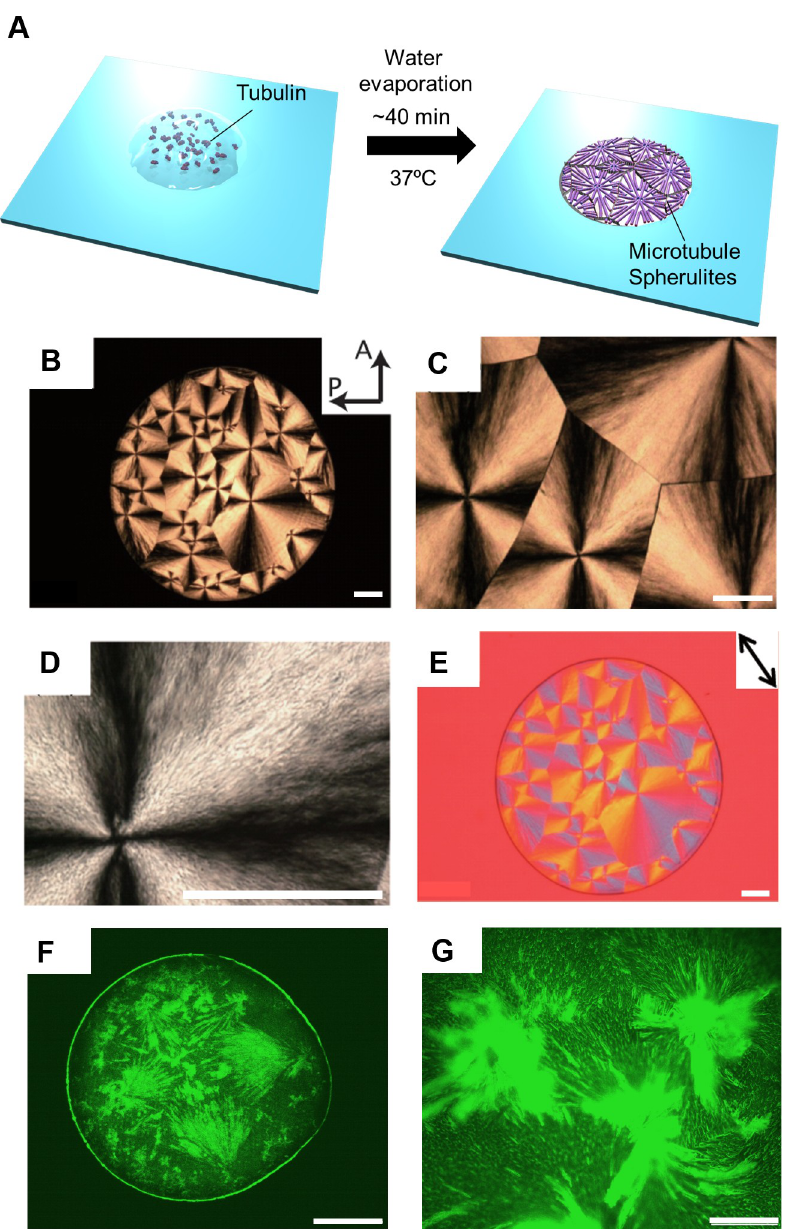
Fig 1. Formation and observation of MT spherulites by polarized and fluorescence microscopy. (A) Schematic illustration of the experimental setup for MTs spherulites formation from an evaporating droplet of the tubulin solution. Polarized optical microscopic images of MT spherulites under (B) 2 × , (C) 4 × , (D) 10 × objective lens and (E) optical retardation. The volume of tubulin solution was used 2 μ L for placing a droplet and concentration was 180 μ M. The tubulin solution was evaporated at 37 o C. The images were captured after 40 min of evaporation. Scale bar: 1 mm. The arrows A and P represent the analyzer and polarizer directions. The arrow in (E) indicates the direction of the sensitive color plate. (F, G) Fluorescence microscopy images of MT spherulites stabilized with taxol buffer by evaporation at 37 o C. Scale bar: 1 mm (F) and 100 μ m (G). Fig 2A shows time-lapse polarized microscopy images of the emergence of the Maltese Crosses pattern in the droplet upon heating. After 10 min of heating at 37 ˚C, the pattern appeared (S2A Fig), and the diameter of the pattern increased with time at growth rate of